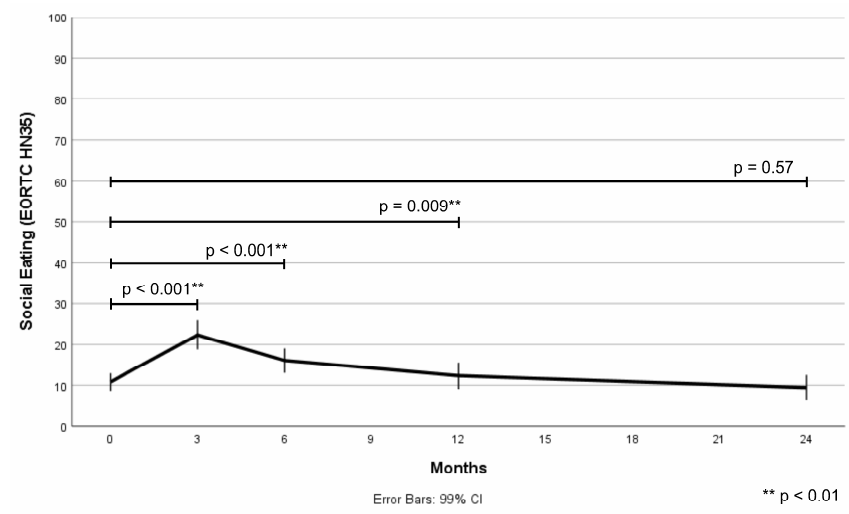
Figure 2. The change in social eating problems (EORTC QLQ HN35) from baseline to 24 months after treatment. Table 2. The change in social eating problems from baseline to 24 months after treatment: observed and estimated values.